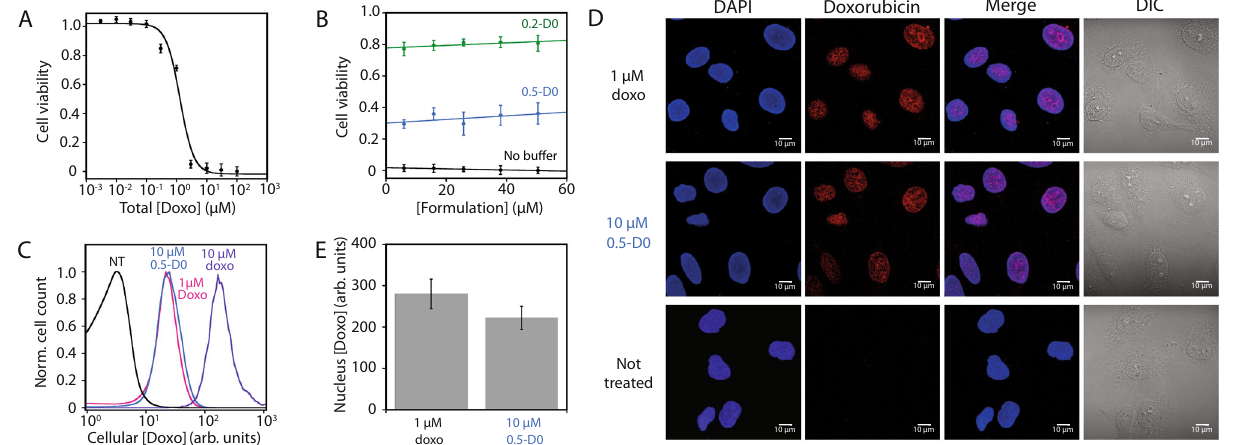
Fig. 3 | In vitro validation of the doxorubicin programmable molecular buffer (D0).A CytotoxicityofdoxorubicinonHeLacellswasassayedwithresazurin( n =8 biologically independent samples). Data fi tted with equation E21 (see Supplemen- tary Information) and are presented as mean values±SD. B The 0.5-D0 (blue line) and0.2-D0(greenline)formulations,programmedtomaintaindrugconcentration near 1 μ M and 300nM, respectively (see supplementary Table 2 and equation E9), provided a cell viability level matching these free drug concentrations even at a very high doxorubicin concentration of 50 µ M ( n =8 biologically independent samples). Data fi tted with linear regression are presented as mean values± SD.